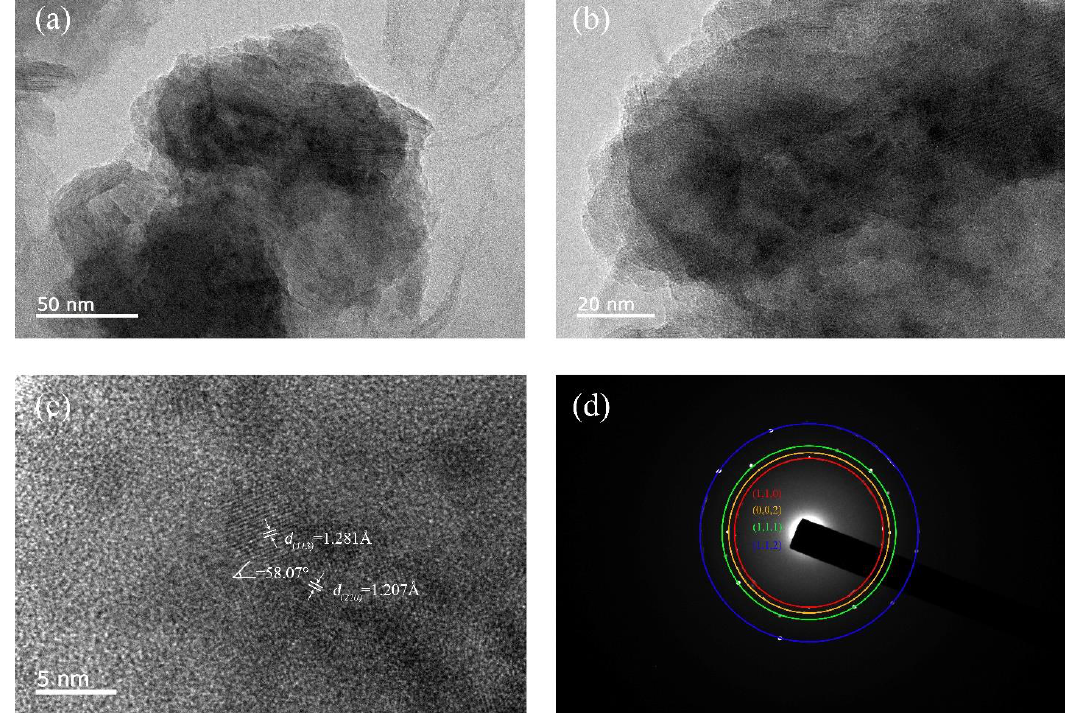
Figure 3. ( a , b ) are the bright-field TEM images of the sample. ( c ) The HRTEM of the sample, the planes of (113) and (220), and the angle of two crystal planes. ( d ) The SAED of the sample. We measured the Vickers hardness of the re-sintered sample of Mn 2 N 0.86 and deter- mined its hardness to be 7.47 GPa (Figure 4). As is well known, the hardness is related to the elastic and plastic properties of the material. The relevant mechanical properties were also calculated; for the hexagonal system, the Voigt and Reuss methods were used to eval- uate B and G [32] . Several models are available for estimating the hardness of a material [33–38], all of which have unique advantages and disadvantages. With Chen’s model [33] of Hv = 2( k 2 G ) 0.585 − 3 (1), Hv , G , and B are the hardness (GPa), shear modulus (GPa), and bulk modulus (GPa), respectively. The parameter k is the Pugh’s modulus ratio, namely, k = G/B ; our calculated Vickers hardness of Mn 2 N 0.86 is 14.26 GPa, which is close to the previously predicted value of 12.01 GPa [20] but significantly larger than the measured value. From Table 2, we can see that by considering magnetism, its bulk elastic modulus is overestimated compared with the previous results [20], which also leads to its B/G > 3. Pugh proposed that the B/G ratio should represent a measure of the machinable behav- iour. The critical value that separates ductile and brittle materials is approximately 1.75 [39], and thus, our results revealed that Mn 2 N 0.86 is still brittle. The predicted Vickers hard- ness is always higher than the actual hardness for most synthesised transition-metal– light-element compounds [40–49], regardless of the model that is chosen. We attribute this paradox to the coexistence of high itinerant electrons and the nature of the covalent bond- ing.